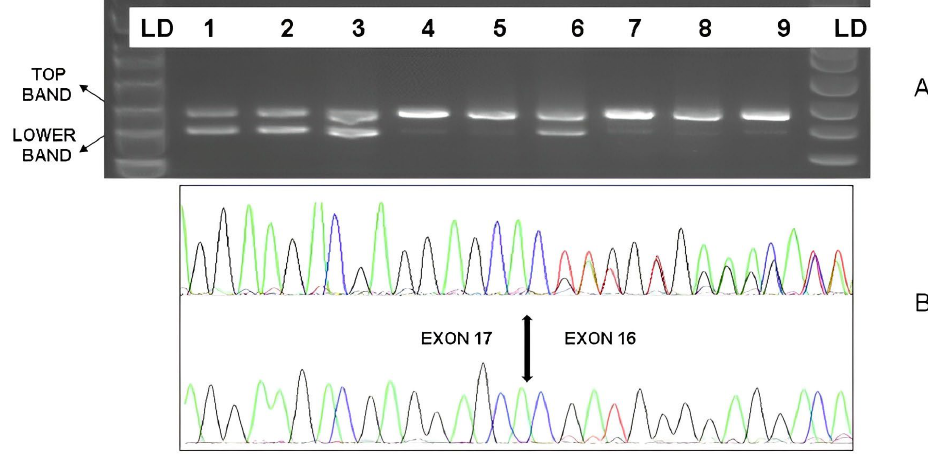
Figure 3. ( A ). Amplification of cDNA fragments from patients with (1,2,3,6) and without (4,5,7,8,9) and the LDLR intron 16 + 4 (c.2389+4 A>G) variant. The cDNA from leukocytes of heterozygous carriers showed two bands of the normal size (exon 16 present) and a shorter band that corre- sponded to the fragment lacking exon 16. ( B ). Sanger sequence (reverse strand) of PCR fragments from patients with (above sequence) and without (below sequence) the intron 16 variant. The am- plification of the fragment without exon 16 resulted in two peaks with overlapping exon 16 and exon 15 sequences. ( C ) The top and lower bands from patients were excised from the agarose gels and sequenced, showing the normal exon 15–16 and alternative exon 15–17 sequences. One male patient was a homozygous carrier of the LDLRAP1 c.207delC pathogenic variant. He was a 39-year-old male who had been diagnosed with dyslipidaemia at the age of 13, with 376 mg/dl being his highest LDLc recorded level. He also presented corneal arcus and tendon xanthomas, giving him the higher punctuation in the DLCN score from the cohort. However, he had no family history of dyslipidaemia nor premature ASCVD. Family screening confirmed that each parent was an asymptomatic carrier of one of the autosomal recessive pathogenic variants. 4. Discussion In most patients, FH is caused by a single pathogenic variant in the three primary genes associated with heterozygous autosomal dominant FH [10]. Therefore, genetic test- ing for patients with suspected FH should, at a minimum, include the analysis of LDLR , APOB , and PCSK9 [10]. More than 90% of reported FH-causing variants are in the genes encoding the low-density lipoprotein receptor ( LDLR ; OMIM #606945). In our cohort, as expected, most genetically confirmed FH patients had LP/P variants in this gene . LDLR LP/P pathogenic variants can be produced by numerous mechanisms including nonsense, missense, and a few synonymous variants; variants in the promoter and canonical splice sequences; and small insertions and deletions and large DNA rearrangements [23,24]. In our cohort, most pathogenic variants in LDLR were missense, followed by those which affect the splicing and nonsense variants. In this Spanish cohort, LDLR c.2389+4A>G was